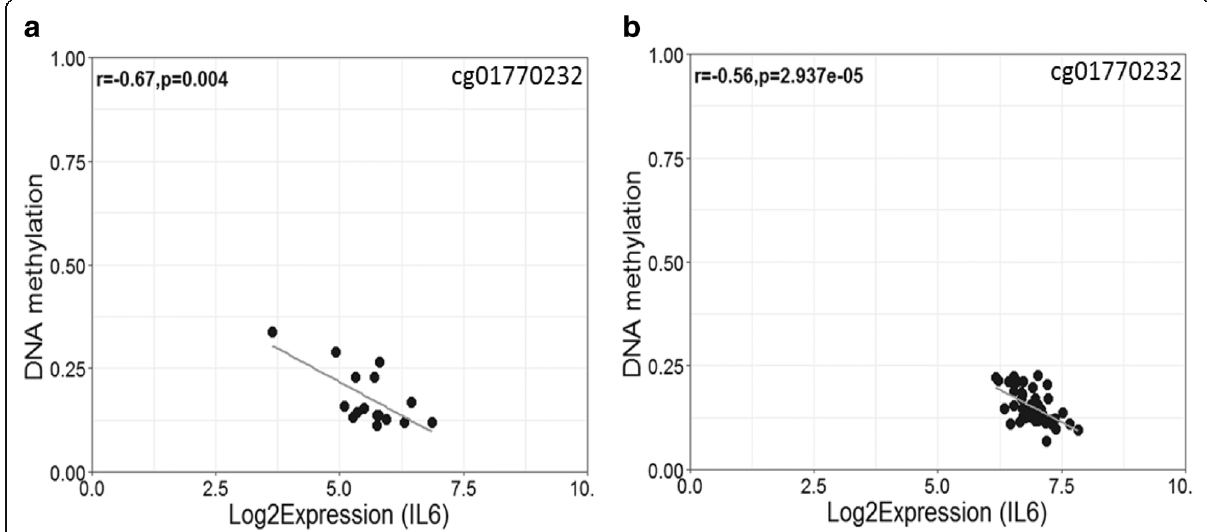
Fig. 4 Placental DNA methylation at cg01770232 is associated with IL6 gene expression. DNA methylation at the IL6 CpG site was negatively correlated with IL6 log2 transformed gene expression in chorionic villi from a ) GSE44711; GSE44667 ( r = − 0.67, p = 0.004), and b ) GSE98224 ( r = − 0.56, p =